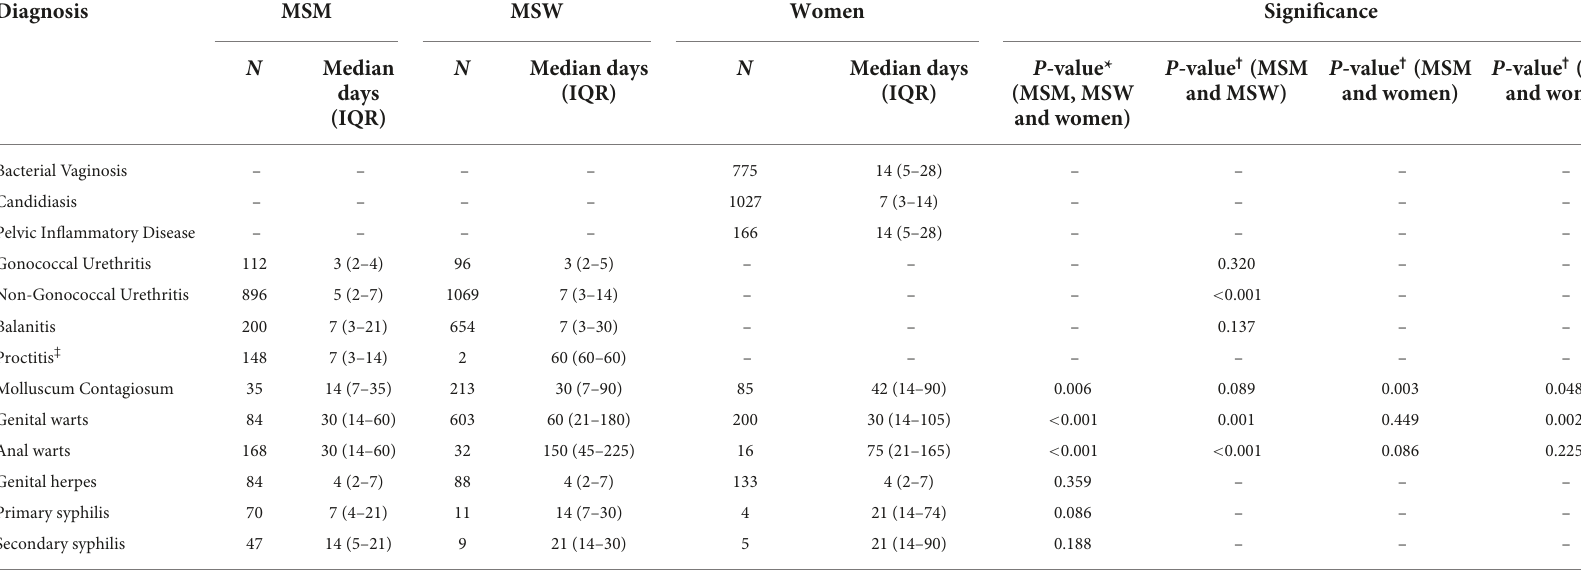
TABLE 1 Time to healthcare seeking following symptom onset in days by risk group, by diagnosis.